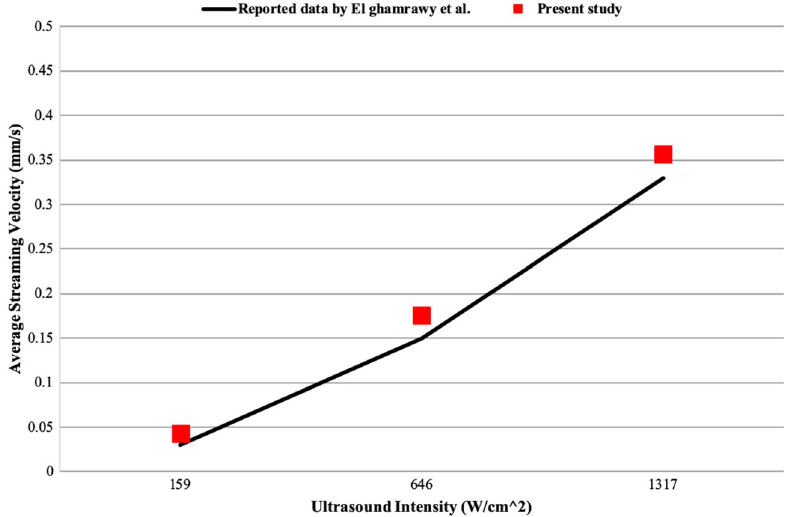
Figure 4. Validation of the numerical method by calculating average streaming velocities. The continuous line represents the results of El-ghamrawy et al. 29 , and the red squares denote the results of the present study.